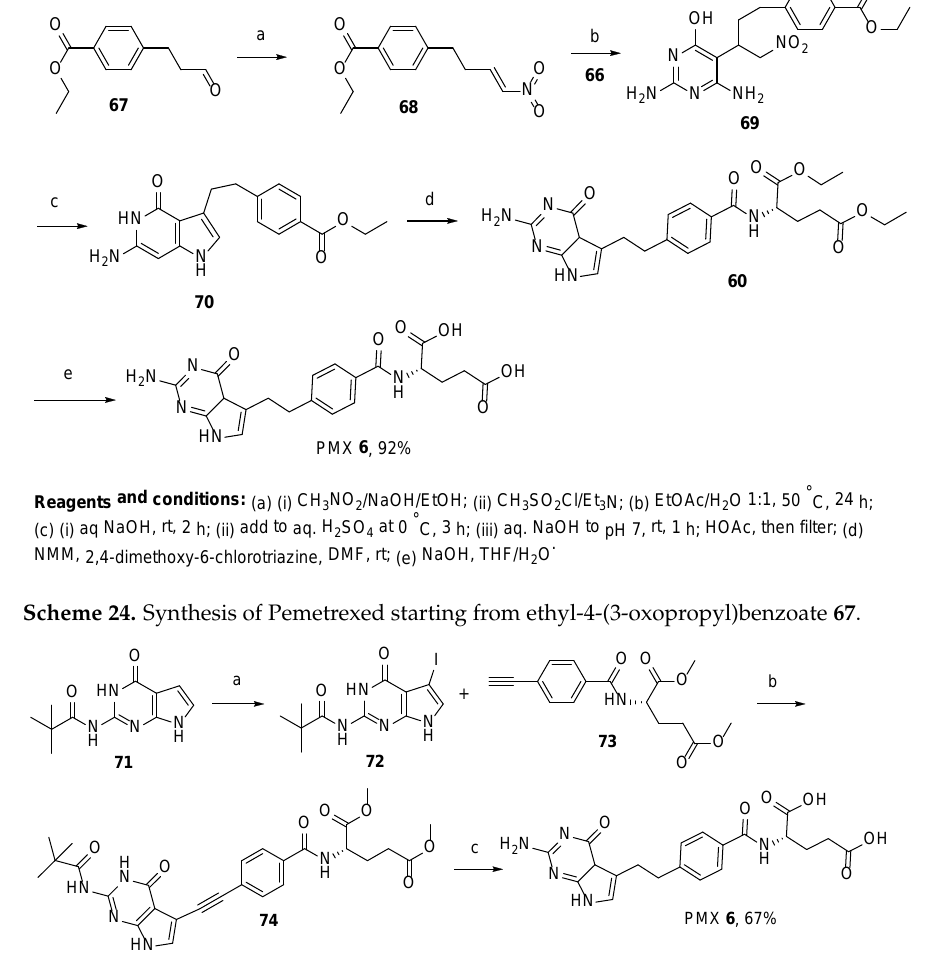
N -(4-oxo-4,7-dihydro-3 H -pyrrolo[2,3- d ]pyrimidin-2-yl)pivalamide 71 .